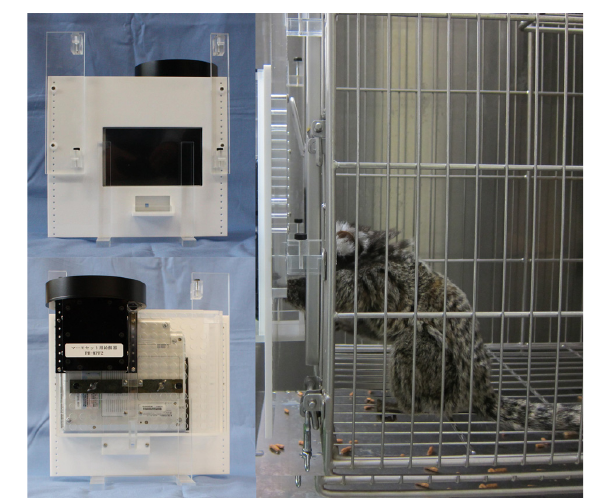
FIGURE 1 | Apparatus. Front view of the apparatus (top left). The apparatus was 30 cm (W) × 20 cm (D) × 25 cm (H) in size, and the screen was 154 mm (W) and 91 mm (H) in size (1024 pixels × 600 pixels). A food tray was located underneath the screen. Back view of the apparatus (bottom left). A black USB-powered feeder was attached to the acrylic panel. A marmoset touching the screen (right). The marmoset typically crouched in the testing cage to touch the screen or pick up a reward. The distance between the screen of the apparatus and the front panel of the cage was approximately 45 mm.